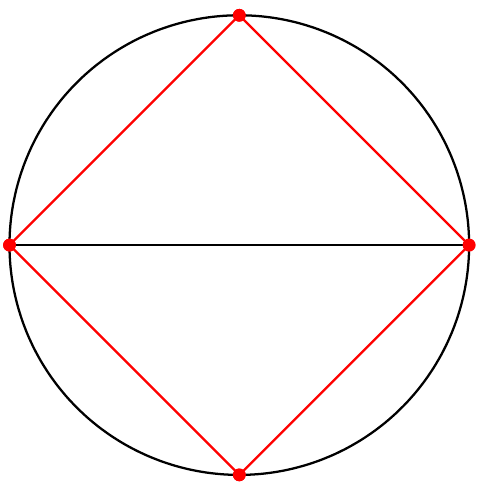
Figure 4 . Graphical representations of solutions in k = 4 model with J = 1 boundary conditions. The initial 1 -brane divides the circle in two halves. The first solution in this subsection is represented by the four red lines, the second solution by the two red points that lie on the black line and the third solution by the two red points at the top and bottom of the